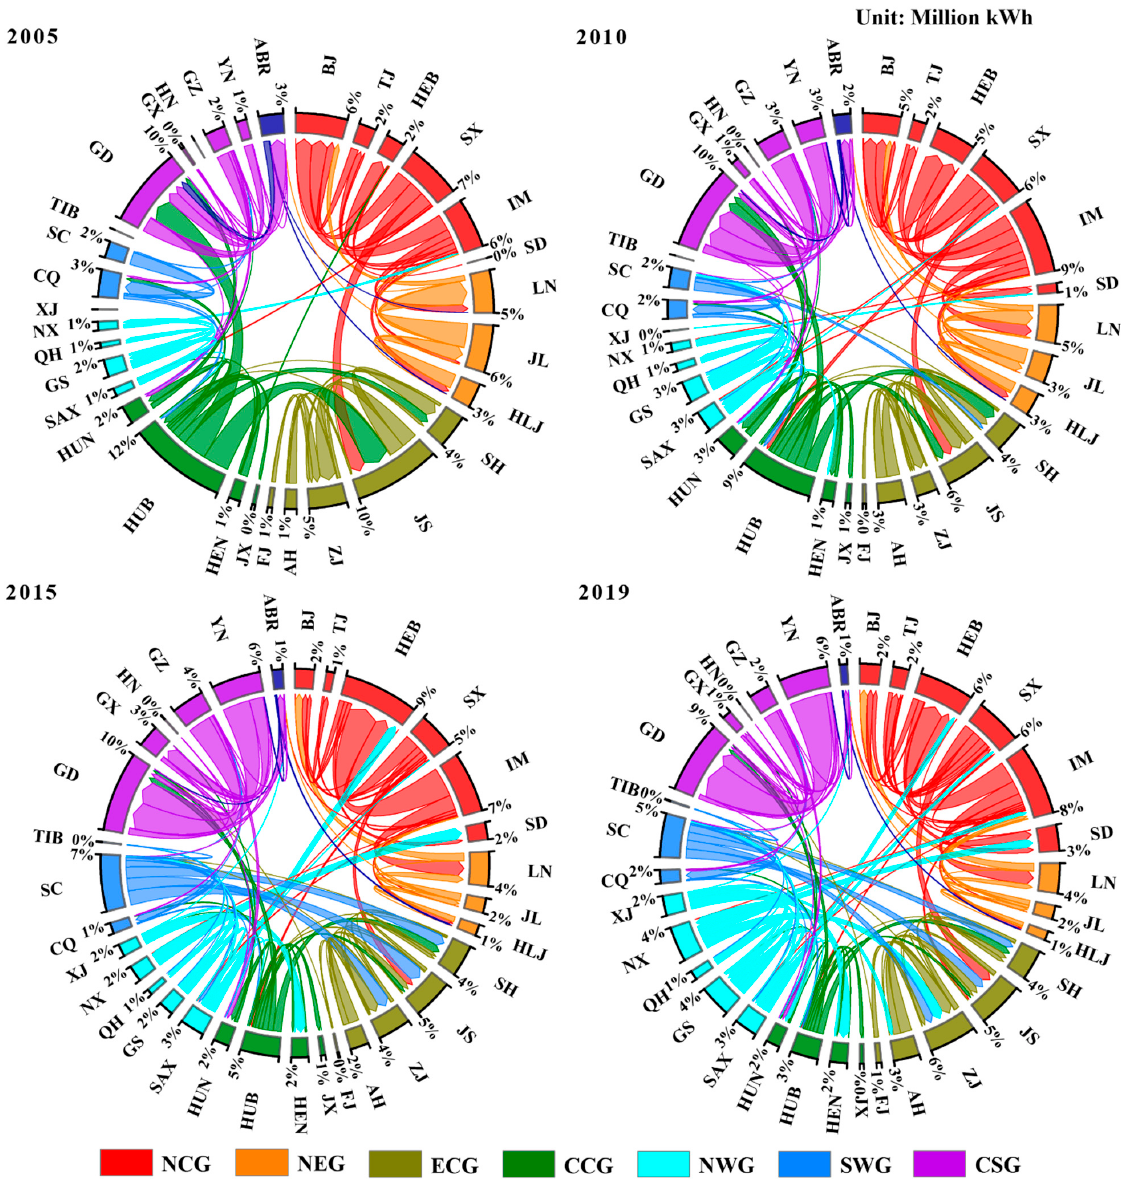
Figure 3. China’s inter-provincial electricity trading flows in 2005, 2010, 2015, and 2019. China’s inter-regional and inter-provincial power transmission networks were rapidly promoted in 2000 as the “West to East power transmission project” and the “Three Gorges power transmission and transformation project” entered the peak period of construction and the construction of UHV transmission lines began. Analysis of trans-regional power transmission data showed that Shanxi transmitted 11.60 billion kWh to Jiangsu, Inner Mongolia transmitted more than 5 billion kWh to Liaoning and Heilongjiang, and Hubei transmitted 6.74 billion kWh, 20.34 billion kWh, 3.086 billion kWh, and 18.301 billion kWh to Shanghai, Jiangsu, Chongqing, and Guangdong, respectively, in 2005. In addition, though the results did not show large amounts of cross-regional power transmission between the seven regional power grids, the inter-provincial power transmission within SNGs was significant. Analysis of NCG data showed that Shanxi and Inner Mongolia were the main transmission provinces, supplying more than 30 billion kWh of electricity. NEG results indicated that Jilin transmitted 18.58 billion kWh to